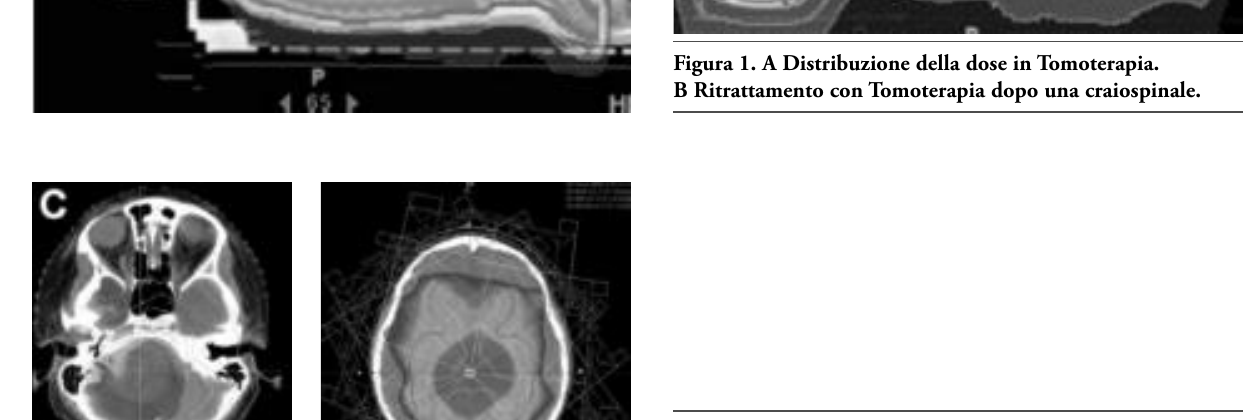
Figura 2. A IMRT per il trattamento dell’ependimoma. B IMRT per l’irradiazione dei ventricoli e